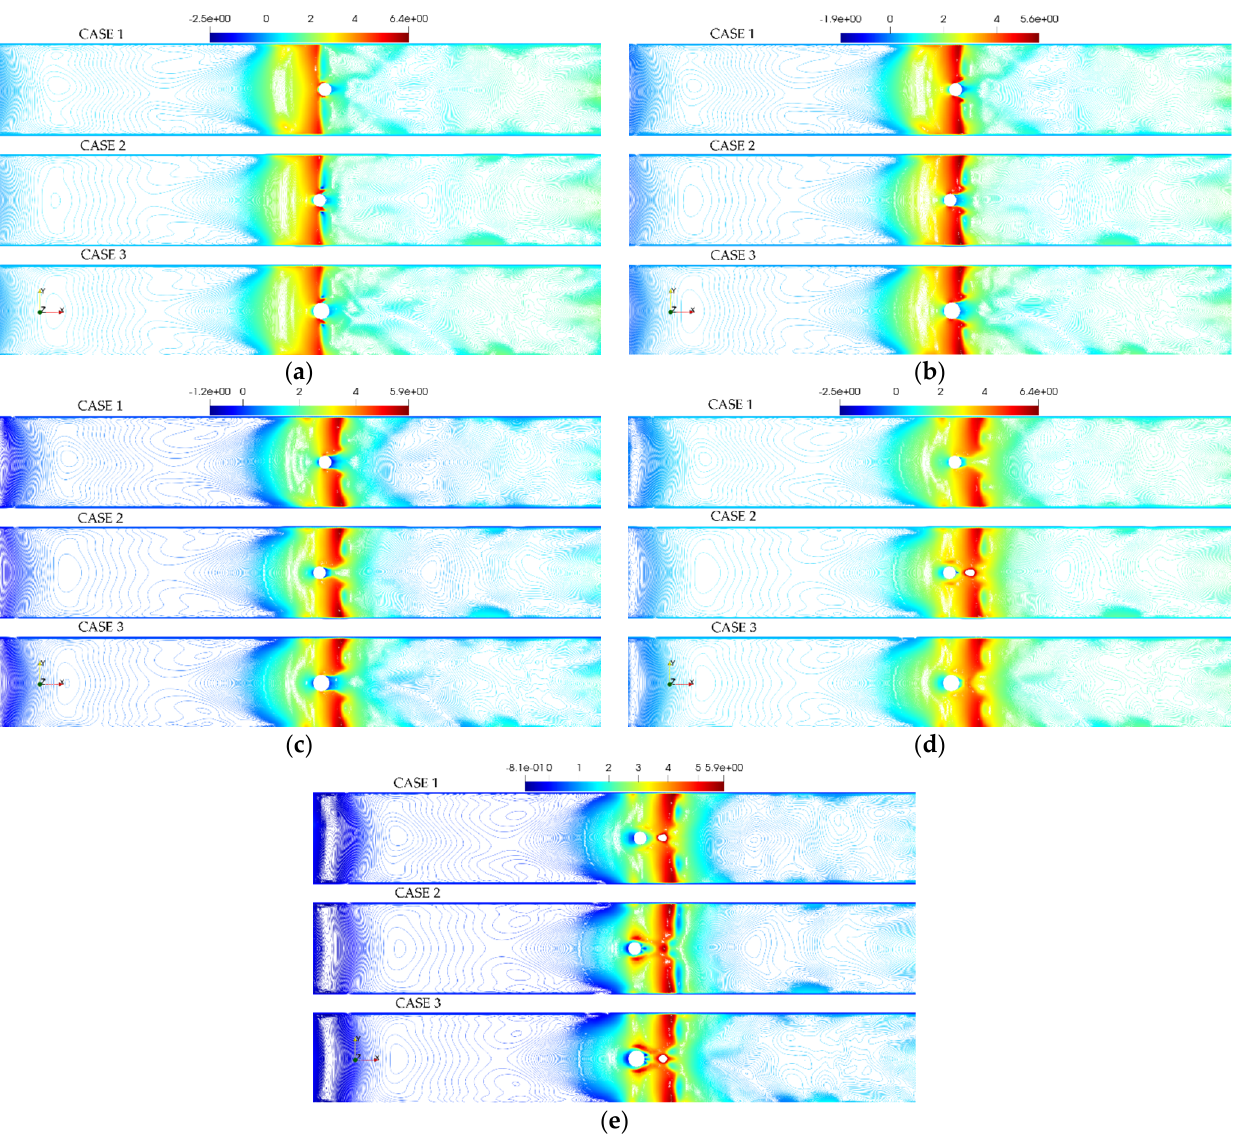
Figure 12. Comparison of velocity distribution in the x -direction for different substructures at various time steps for: ( a ) t = 31.2 s, ( b ) t = 31.3 s, ( c ) t = 31.4 s, ( d ) t = 31.5 s, and ( e ) t = 31.6 s.